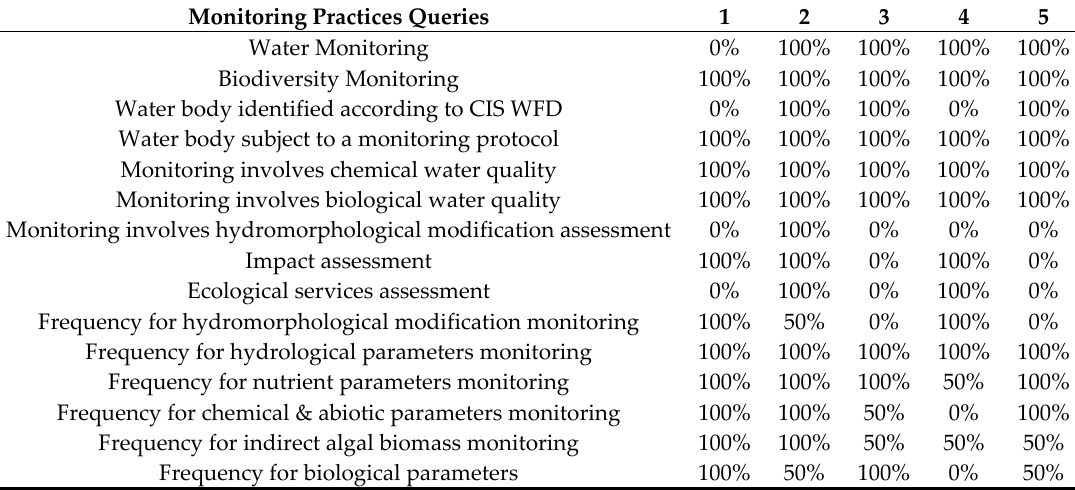
Figure 2. Gap rating on Water Quality and Pressures for each of the five PAs. Table 1. Percentages of Gap Analysis of the five PAs regarding the Monitoring Practices. 1: L’ Albufera, 2: Krka, 3: Mincio, 4: Una, 5: Karla.